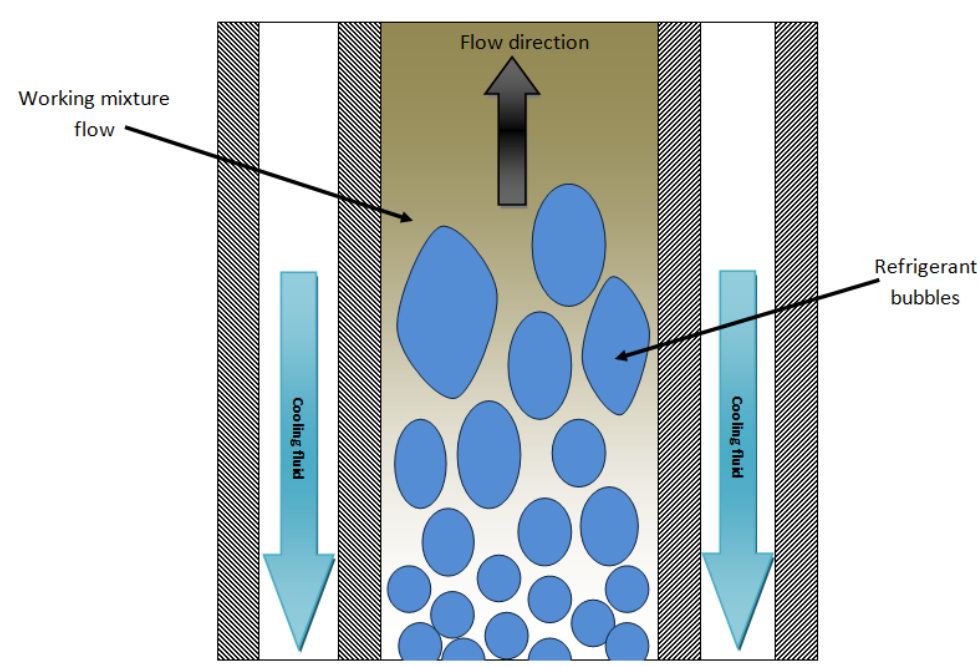
Figure 4. Bubble absorber